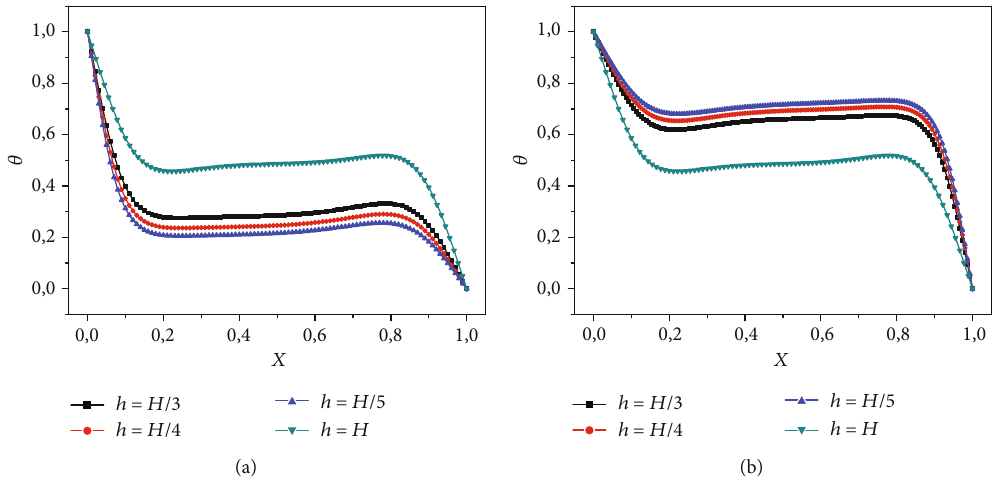
Figure 10: Temperature pro fi les for Ra = 10 5 and for di ff erent hot (a)/cold (b) chip lengths ( h = H , h = H /3, H /4 , and h = H /5 ).